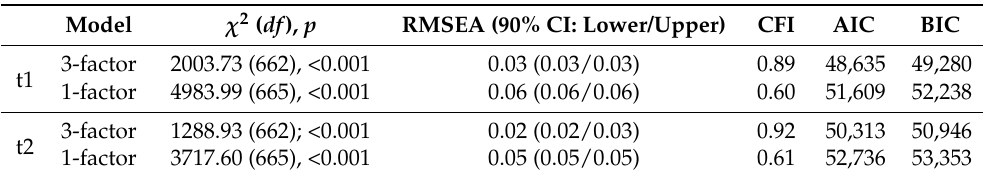
Table 2. Results of confirmatory factor analyses of the three working memory tasks at t1 ( n = 1825) and t2 ( n =